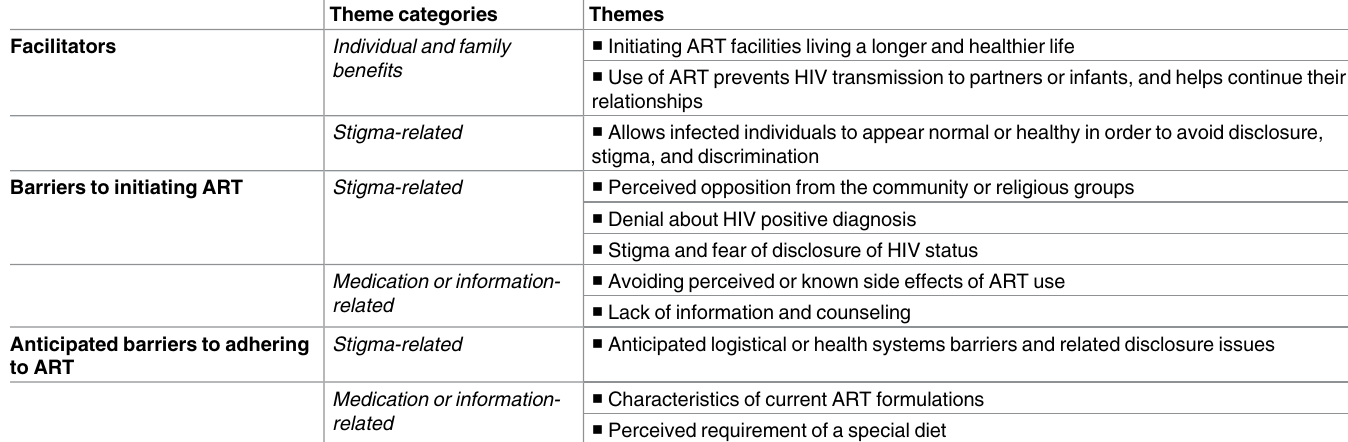
Table 2. Facilitators and barriers to initiating ART among serodiscordant